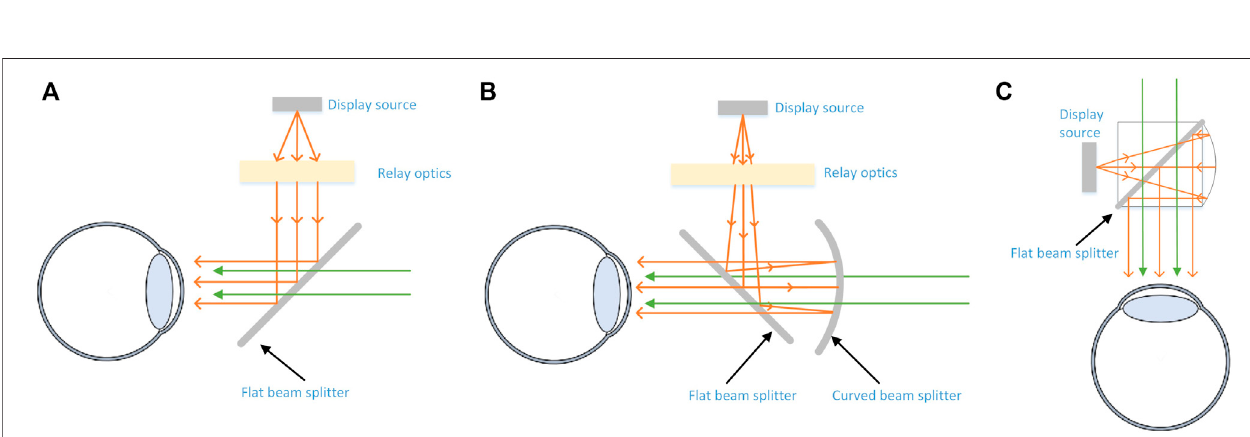
FIGURE 7 | Schematic diagram of a CGH setup. Computer generated holographic interference patterns will be displayed on the SLM and the 3D image will be reconstructed by projecting the laser light onto the SLM.